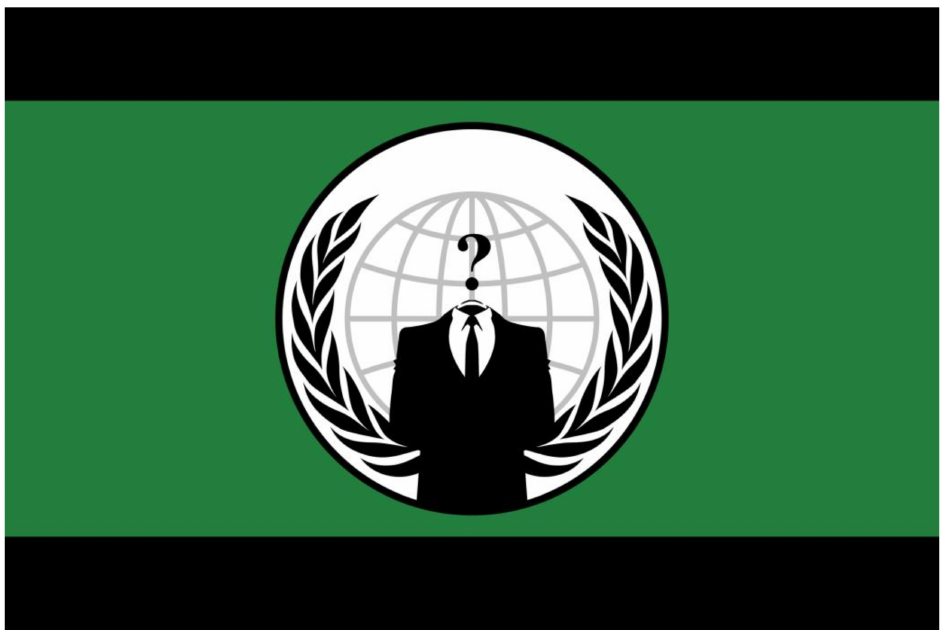
Figure 1. Flag of the activist hacker group known as Anonymous (Anonymous